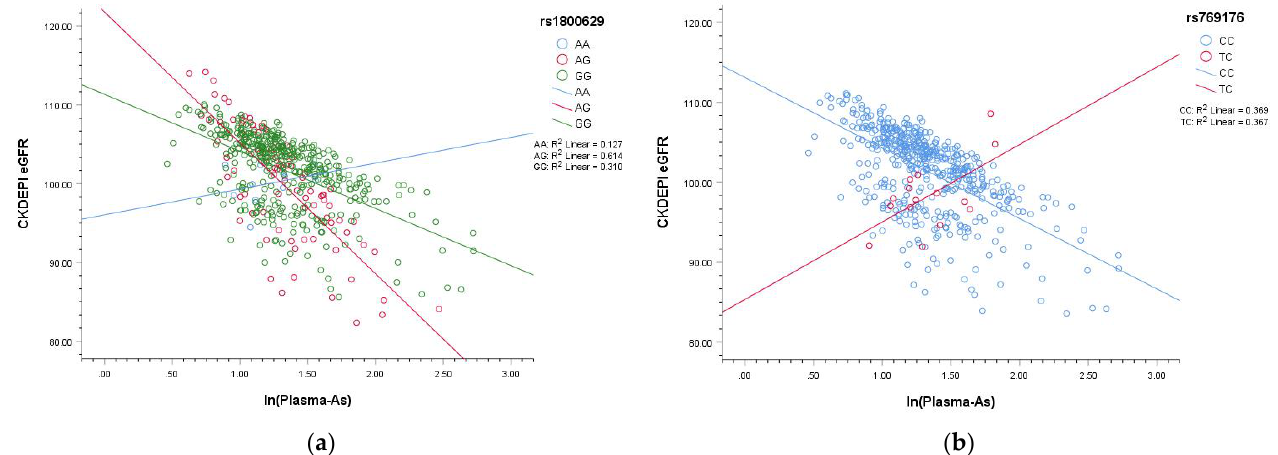
Figure 1. Plots showing interaction of natural log-transformed plasma arsenic (As) and SNPs. ( a ) Interactions with rs1800629 types AA and GG were not significant; however, rs1800629 AG significantly interacted with plasma As levels to decrease CKDEPI eGFR. ( b ) There were only CC and TC types for rs769176; the cross lines show a significant interaction between these types and plasma As levels. Participants with the TC type of rs76179 would be more robust to As exposure than CC carriers; however, the numbers were too small, and there were no participants with the TT type of rs769176.